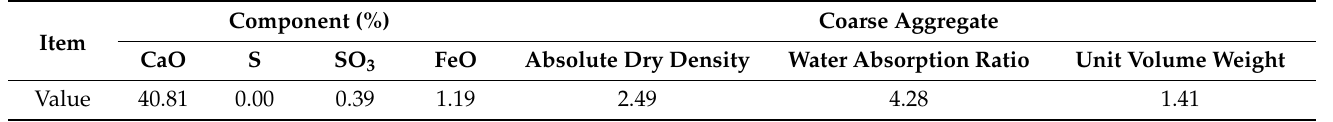
Table 11. Properties of the air-cooled slag coarse